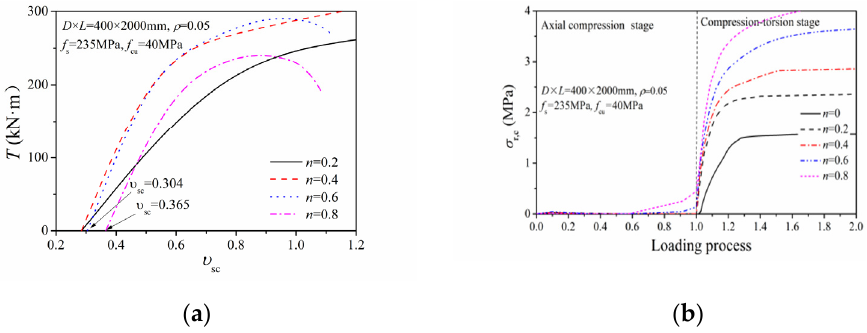
Figure 10. Composite action of steel tube and concrete: ( a ) Relation of load–strain ratio; ( b ) lateral compressive stress of concrete.